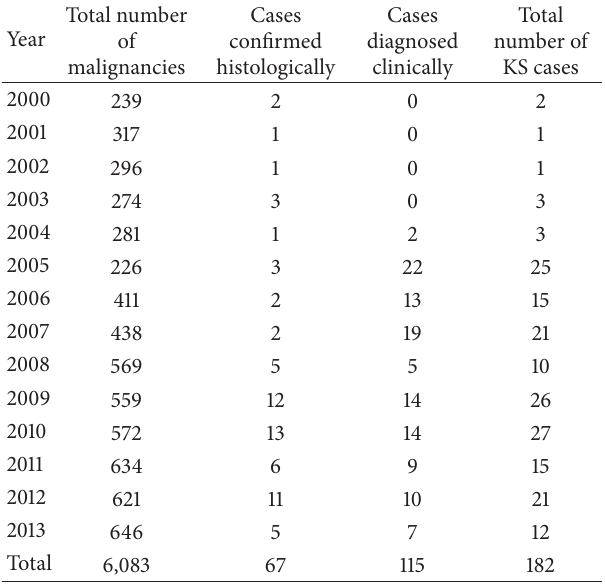
Table 1: Relative frequency of Kaposi